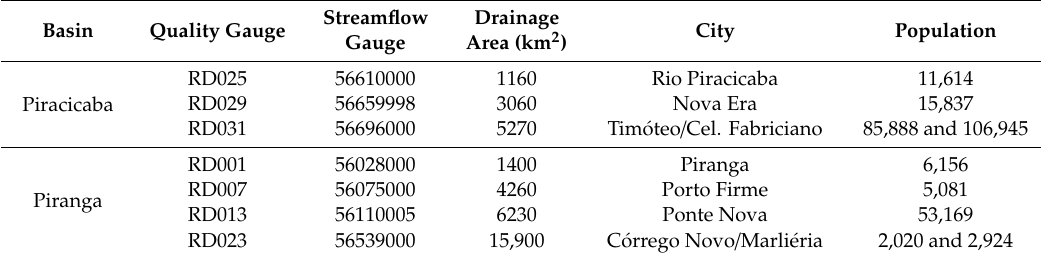
Table 1. List of water quality and streamflow gauges used in the study, with the upstream drainage area. Information is also provided for the cities where the gauges are located, namely city name and their